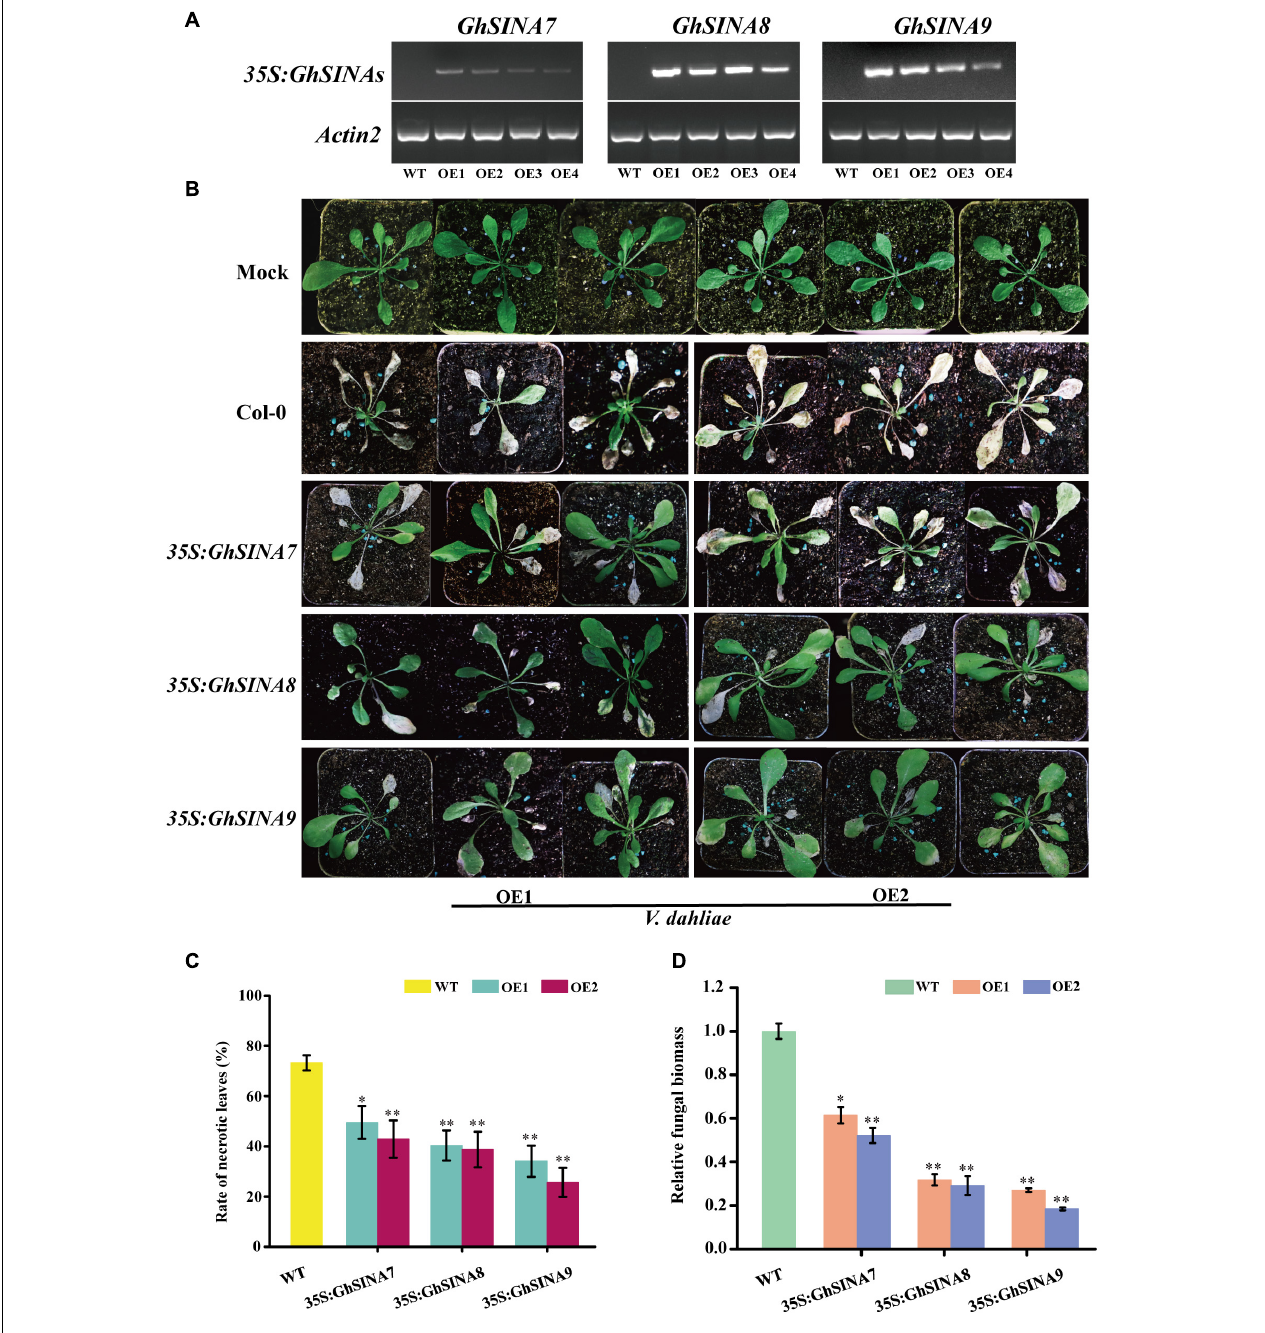
FIGURE 5 | Enhanced disease tolerances of Arabidopsis plants independently overexpressing GhSINA7 , GhSINA8, and GhSINA9 . (A) Identification of transgenic Arabidopsis lines independently overexpressing GhSINA7 , GhSINA8, and GhSINA9 as assessed by RT-PCR. Arabidopsis Actin2 was used as an internal control. (B) Symptoms of wild-type and GhSINA7 , GhSINA8, and GhSINA9 transgenic plants inoculated with V. dahliae for 10 days. (C) Disease rates of necrotic leaves in wild-type and transgenic Arabidopsis plants 10 days after V. dahliae inoculation. Error bars indicate the SDs of three biological replicates ( n ≥ 32). Asterisks indicate statistically significant differences as determined by Student’s t -test ( ∗ P < 0.05, ∗∗ P < 0.01). (D) Quantitative measurement of fungal biomass. DNA of roots were extracted from plants 10 days post-inoculation by V. dahliae . A qRT-PCR analysis was employed to compare the DNA levels between the V. dahliae internal transcribed spacer (ITS) region and the Actin2 gene of Arabidopsis. Error bars represent the SDs of three biological replicates. Asterisks indicate statistically significant differences as determined by Student’s t -test ( ∗ P < 0.05, ∗∗ P < 0.01).